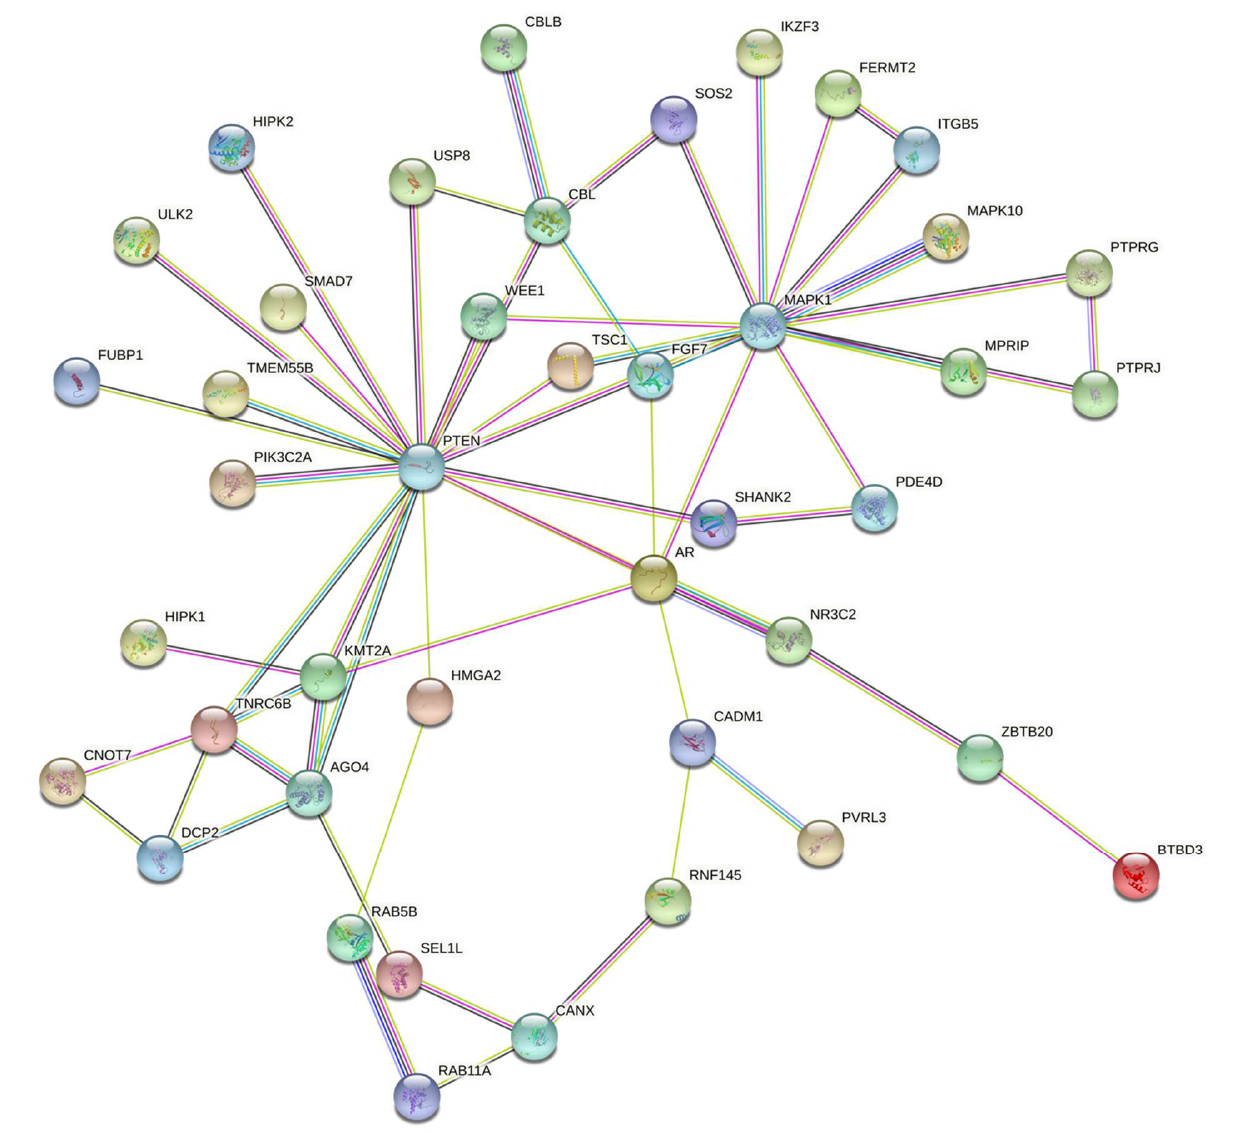
Figure 2. Protein–protein interaction analysis representing the interaction networks of miRNA target proteins, depicting two major clusters (PTEN and MAPK1) in the